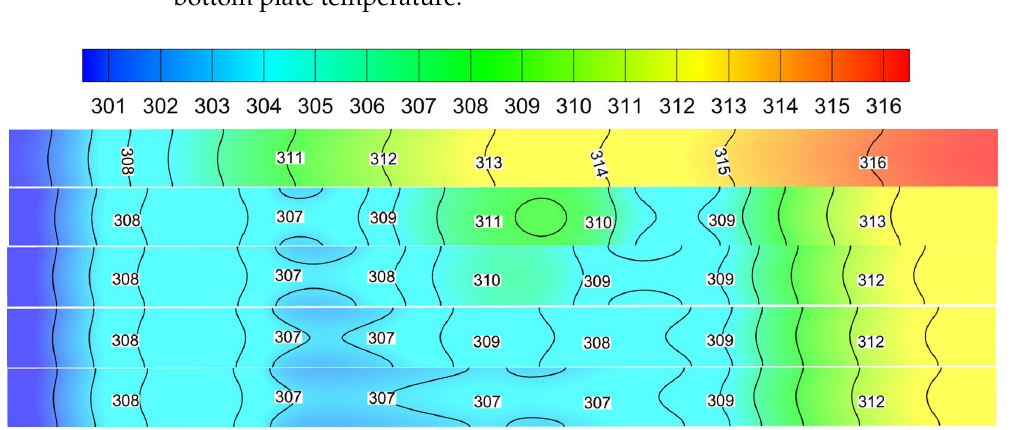
Figure 8. Temperature distribution diagram of Cases 0–4 at the inlet velocity of 1.5 m/s.